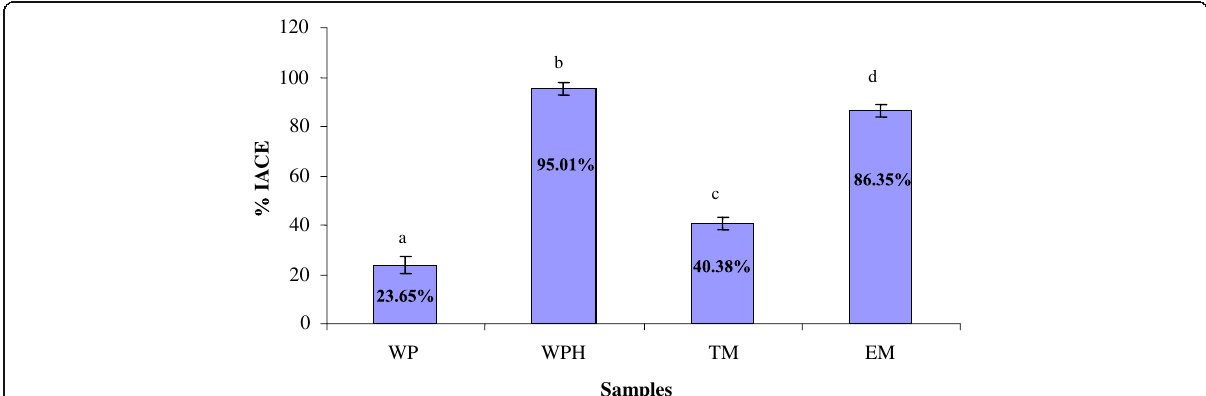
Fig. 5 ACE inhibitory activity in WPC, its hydrolyzate, toned and enriched milks. Different letters on top of the bars indicate significant differences ( p < 0.01). Error bars indicate standard deviation from means ( n =